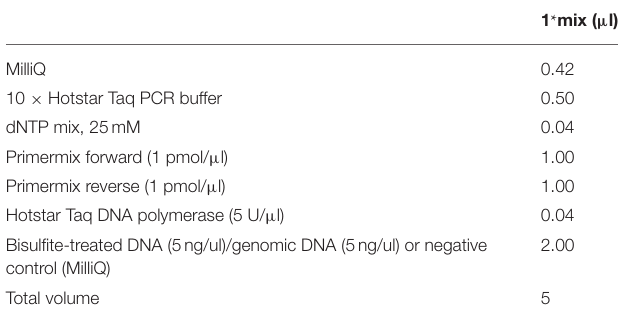
TABLE 1 | The PCR mix for one PCR